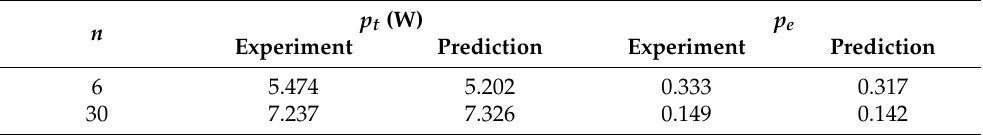
Table 3. Comparison results between experimental data and predicted